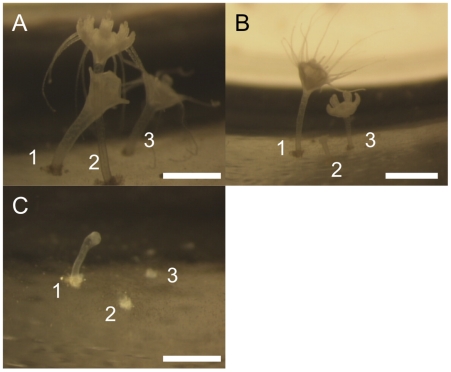
Developmental sequence of strobilating polyps.
A) Polyp #1 after 1 day of strobilation, #2 in monodisc strobilation and #3 completely developed. B) Polyp #1 completely developed after 26 days of strobilation, #2 only stalk after liberating the ephyra and #3 in monodisc strobilation. C) Polyp #1 only stalk after liberating the second ephyra 40 days after liberating the first one, #2 and #3 died and only prints where pedal discs were attached are observed. All scale bars  = 500 µm. Author of the pictures: D. Astorga.